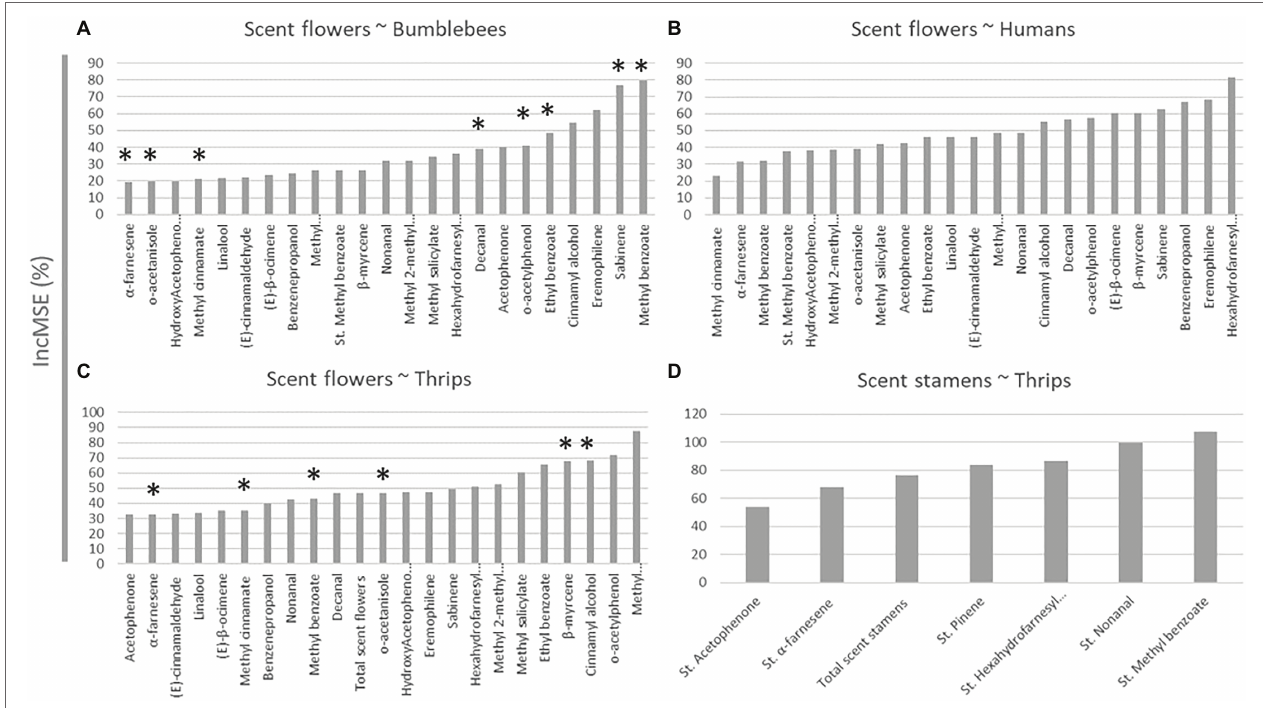
FIGURE 4 | Percentage of the mean square error (%IncMSE) resulting from random forest regression analysis of the preferences of studied animals as the dependant variable and the emission of volatile organic compound (VOCs) as the explanatory variable. (A) Bumblebee preferences against the scent of flowers with stamens. (B) Human preferences against the scent of flowers with stamens. (C) Preferences of thrips for the scent of flowers without stamens. (D) Preferences of thrips for the scent of stamens. Asterisks indicate isolated volatiles that have been used for behavioural assays with bumblebees and